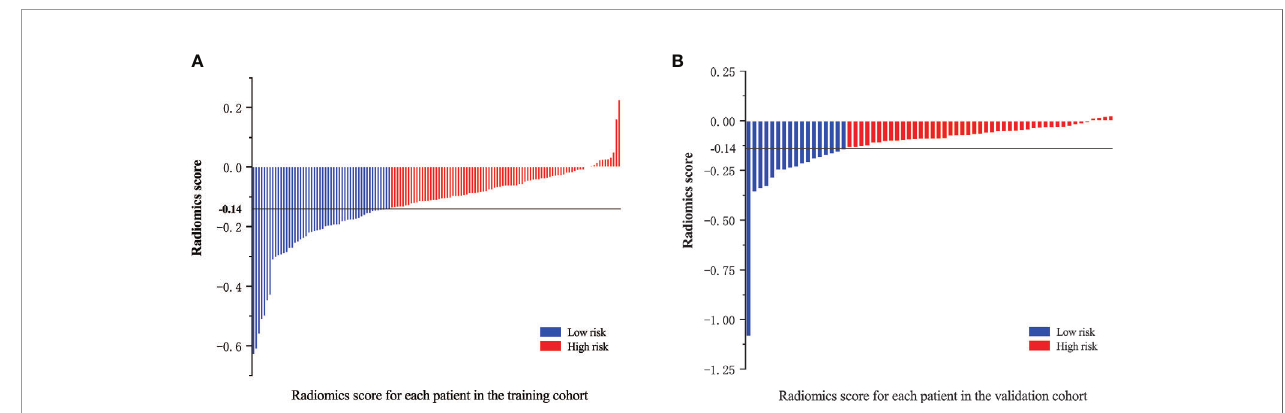
FIGURE 3 | Radiomics scores for each patient in the (A) training cohort and (B) validation cohort; patients were classi fi ed into high and low risk groups with a threshold of −